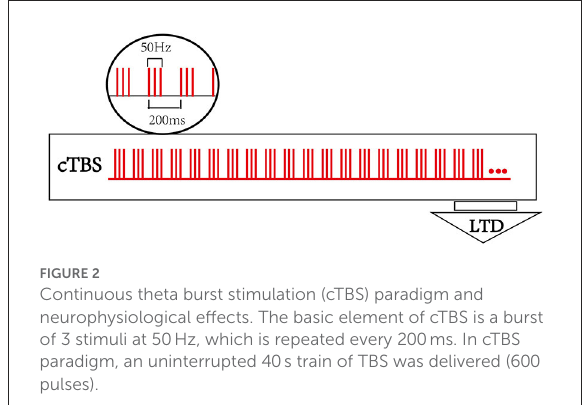
FIGURE2 Continuous theta burst stimulation (cTBS) paradigm and neurophysiological effects. The basic element of cTBS is a burst of 3 stimuli at 50Hz, which is repeated every 200ms. In cTBS paradigm, an uninterrupted 40s train of TBS was delivered (600